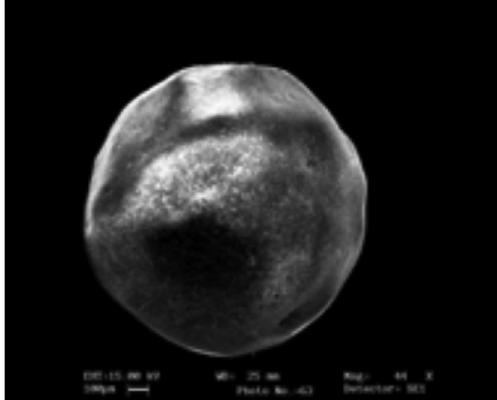
FIGURE 3 - Scanning electron micrograph of stearic acid coated pellets